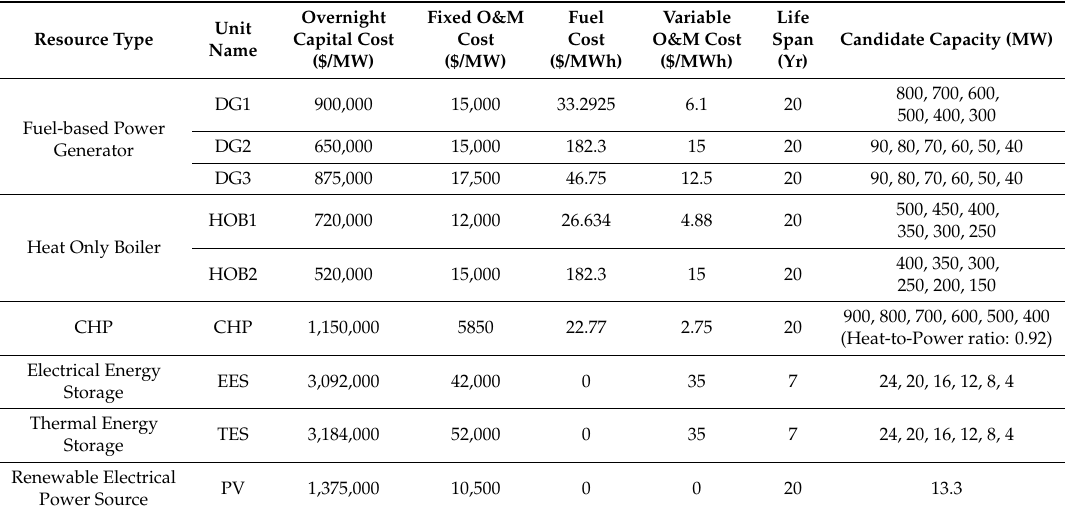
Table 4. Energy resources data (O&M = operations and maintenance).